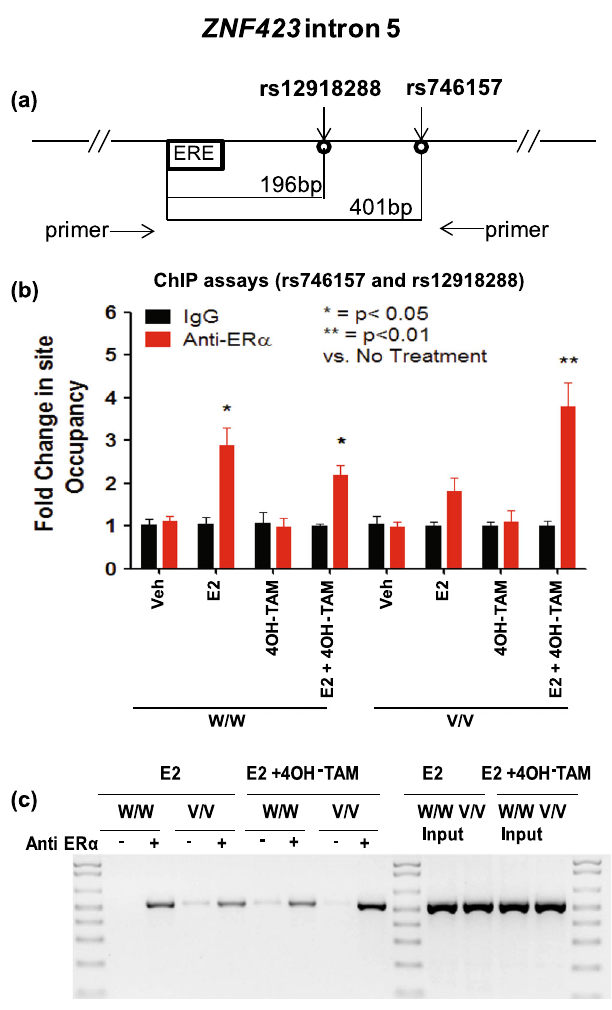
Fig. 3 ChIP assay results for the rs746157 and rs12918288 SNPs in ZNF423 intron 5. a The fi gure shows a schematic representation of the ERE motif located near the rs12918288 and rs746157 SNPs in intron 5 of ZNF423 . b Bar graphs showing quantitative ER α ChIP results for the area of ZNF423 containing rs746157 and rs12918288. The values shown represent mean ± SEM for six determinations. c Agarose gel assay showing differential binding for the region including the rs746157 and rs12918288 SNPs for LCLs homozygous for WT (W/W) or variant (V/V) genotypes for these two SNPs after exposure to E2 (0.01 nM) or E2 (0.01 nM) plus 4OH-TAM (0.01 μ